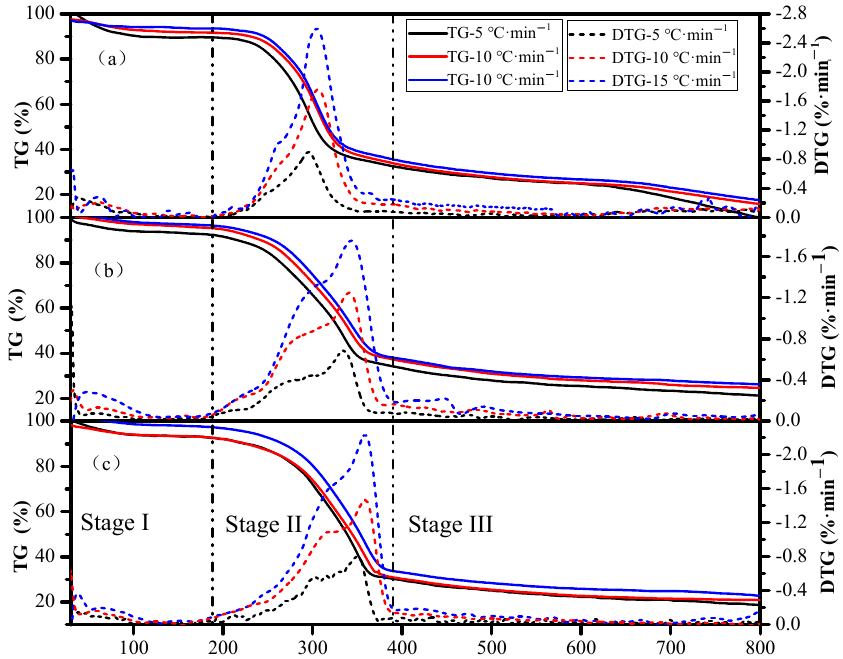
Figure 1. TG and DTG curves of for the pyrolysis of RS ( a ), ATB ( b ), and PS ( c ) at heating rates of 5, 10, and 15 °C·min − 1 . 5, 10, and 15 ◦ C · min − 1